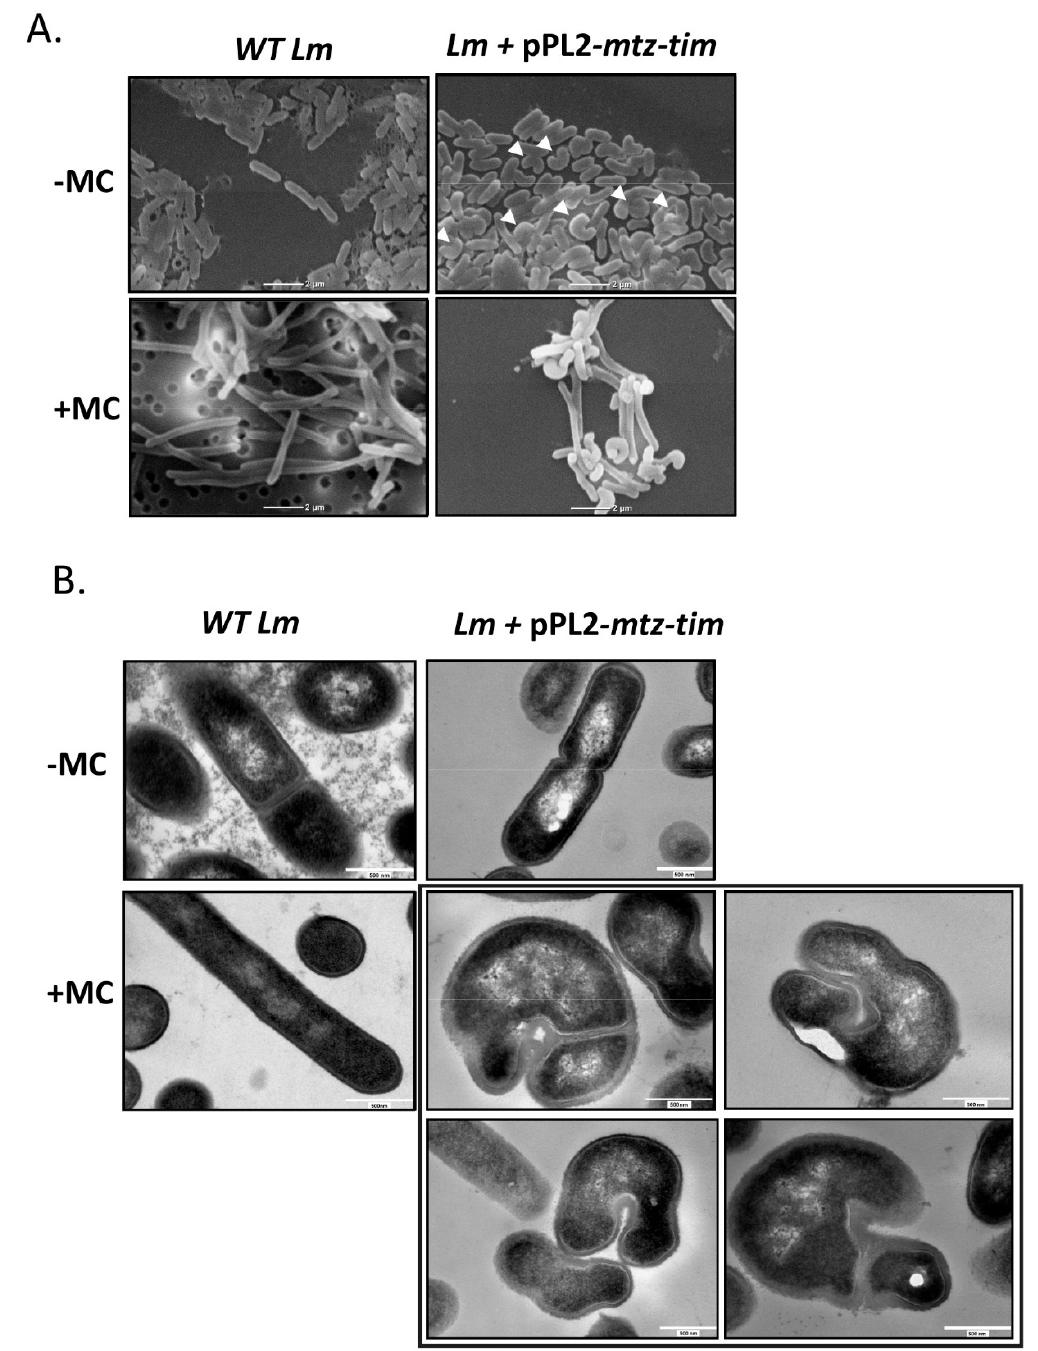
Figure 6. Ectopic expression of Mtz-Tim affects Lm morphology. ( A ) Scanning electron microscopy images of WT Lm bacteria and WT Lm harboring pPL2 plasmid expressing mtz-tim from an inducible p tetR promoter (pPL2- mtz-tim ) grown at 37 ◦ C in BHI with or without MC for 4 h. Experiment was performed 3 times and a representative image is shown. Bacteria with curved morphology indicated with white arrowheads. ( B ) Transmission electron microscopy images of WT Lm bacteria and WT Lm harboring pPL2 plasmid expressing mtz-tim from an inducible p tetR promoter (pPL2- mtz-tim ) grown at 37 ◦ C in BHI with or without MC for 4 h. The gray box contains four images of Lm expressing mtz-tim treated with MC. Experiment was performed 2 times and a representative image is shown.